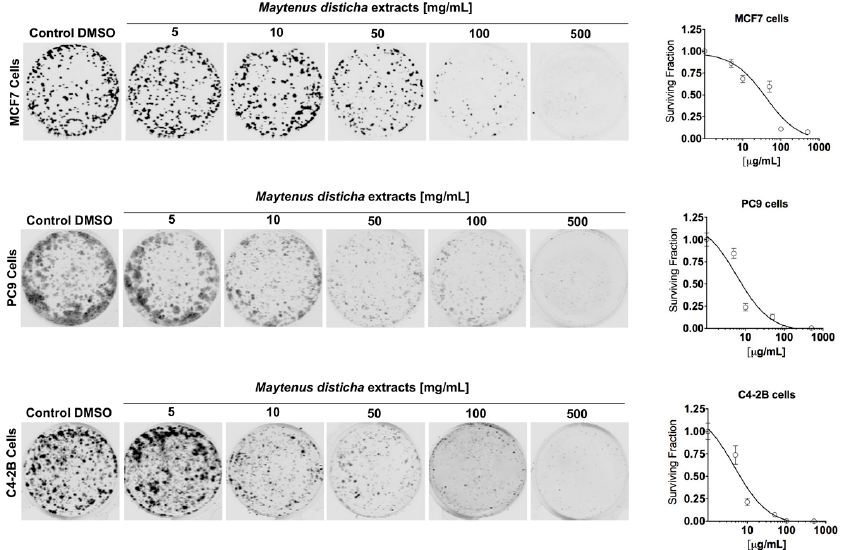
Figure 4. Maytenus disticha extract has cytotoxic effects in human cancer cells. The cytotoxicity was evaluated by clonogenic assay in MCF-7, PC9, and C4-2B cells treated with 5–500 µg/mL of MD extract for 24 h. The IC 50 were calculated using the GraphPad prism software for each cell line.